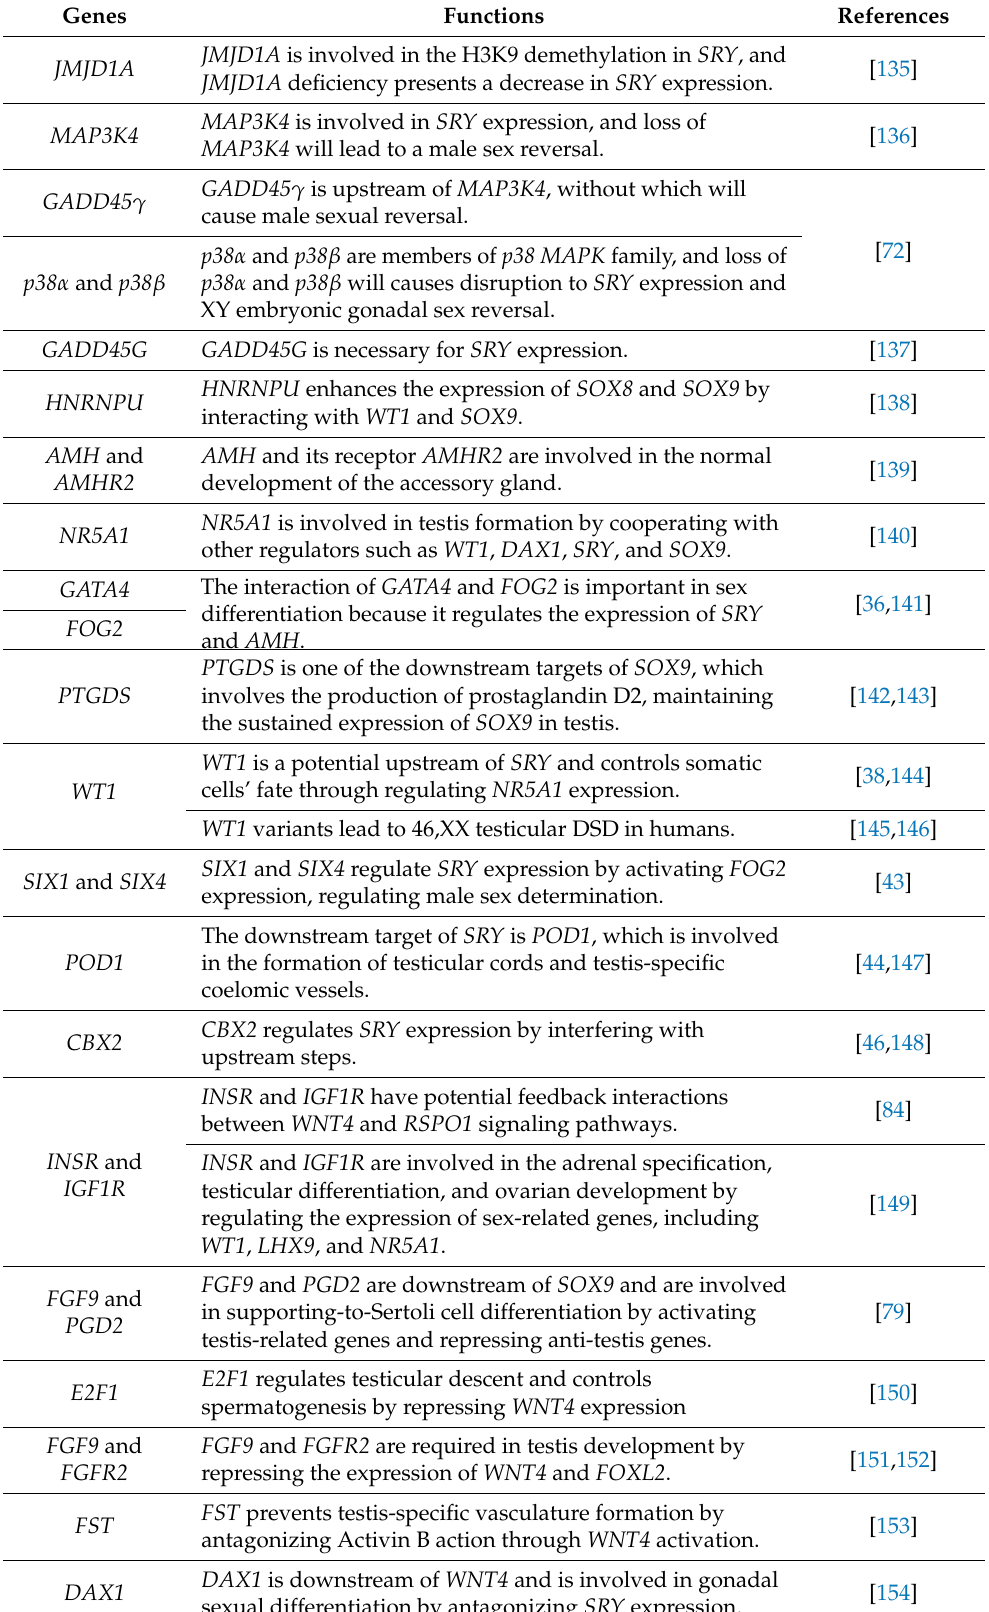
Table 2. Genes involved in gonadal sexual